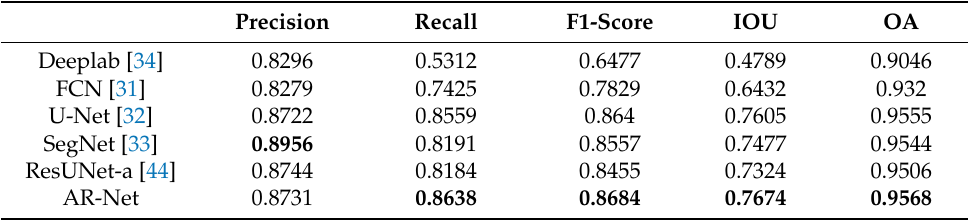
Table 2. Performance comparisons of the six semantic segmentation algorithms for the FIO-AR dataset. The bold numbers represent the maximum value in each